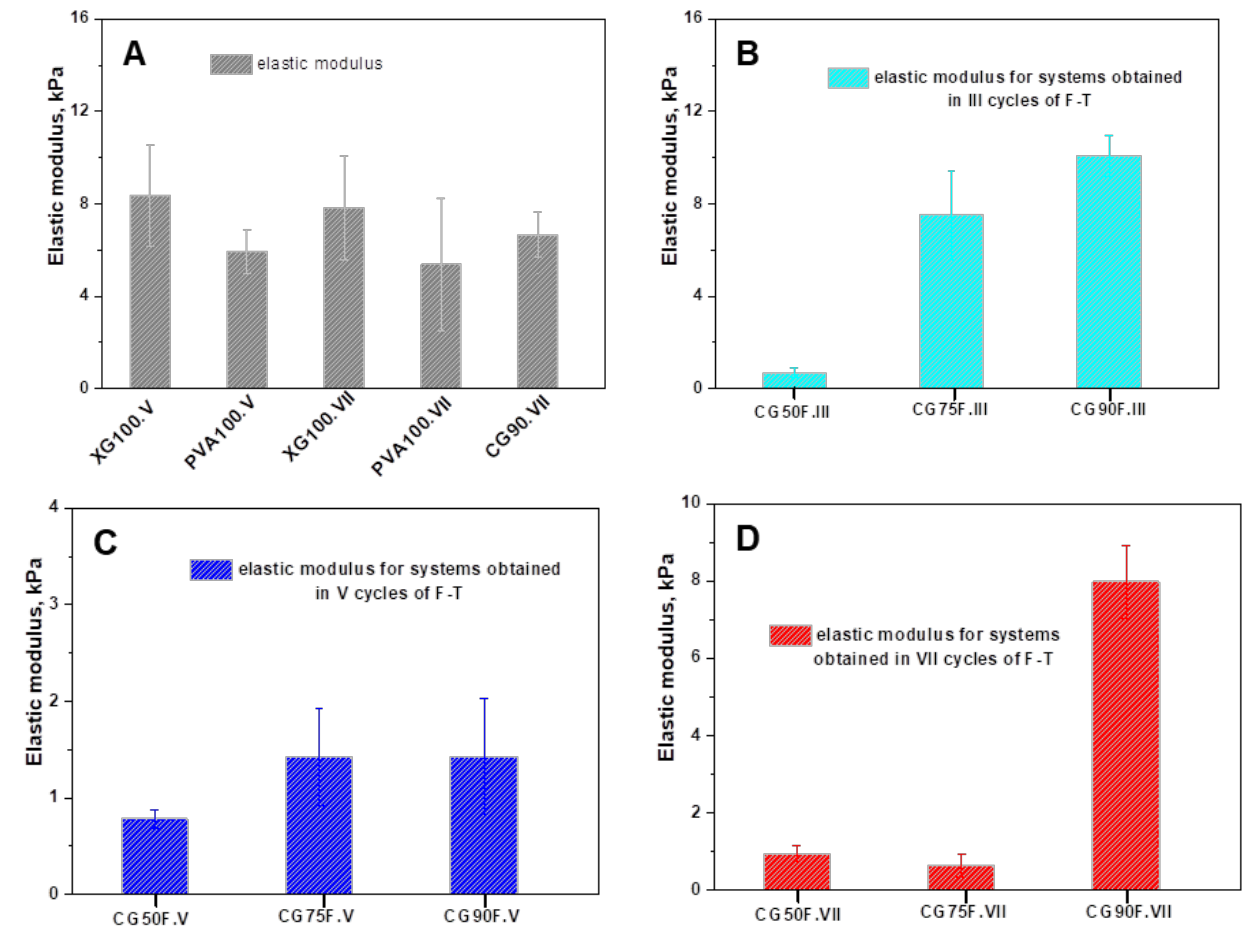
Figure 3. Elastic modulus of the polyphenol-loaded XG/PVA composite hydrogels: ( A ) control samples; ( B ) composite hydrogels prepared in III cycles of F-T; ( C ) composite hydrogels prepared in V cycles of F-T; ( D ) composite hydrogels prepared in VII cycles of F-TAll the data were expressed as the mean of three individual measurements ± SD.